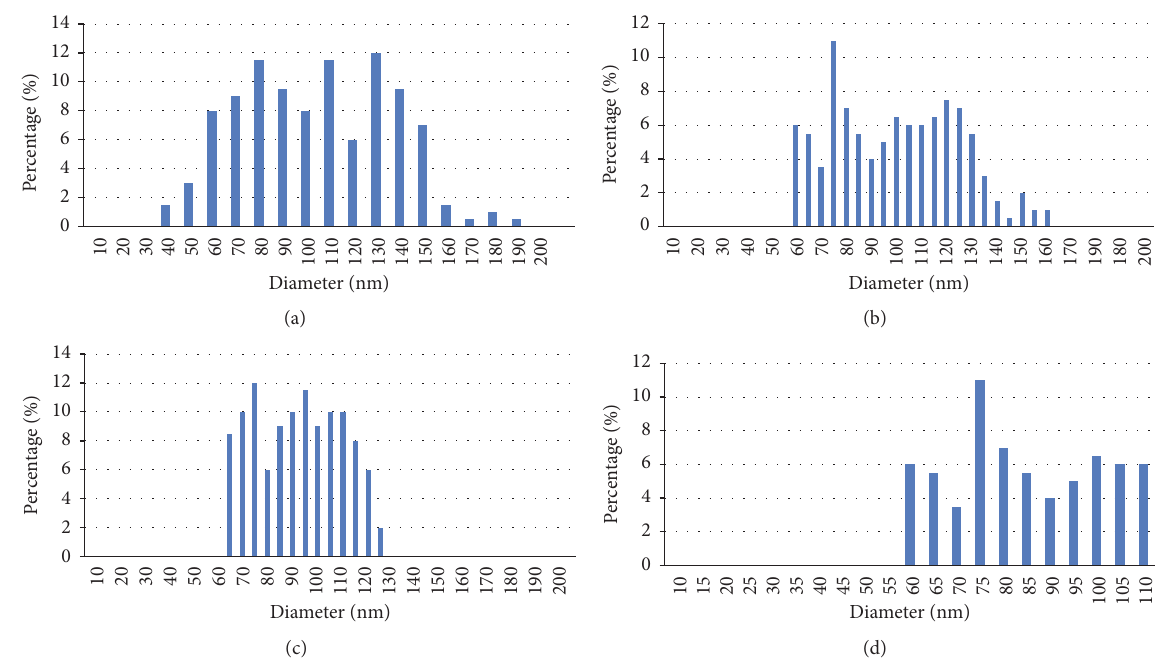
Figure 10: The size distribution for silicon nanoparticles prepared by (a) 700 mJ, (b) 720 mJ, (c) 740 mJ, and (d) 760